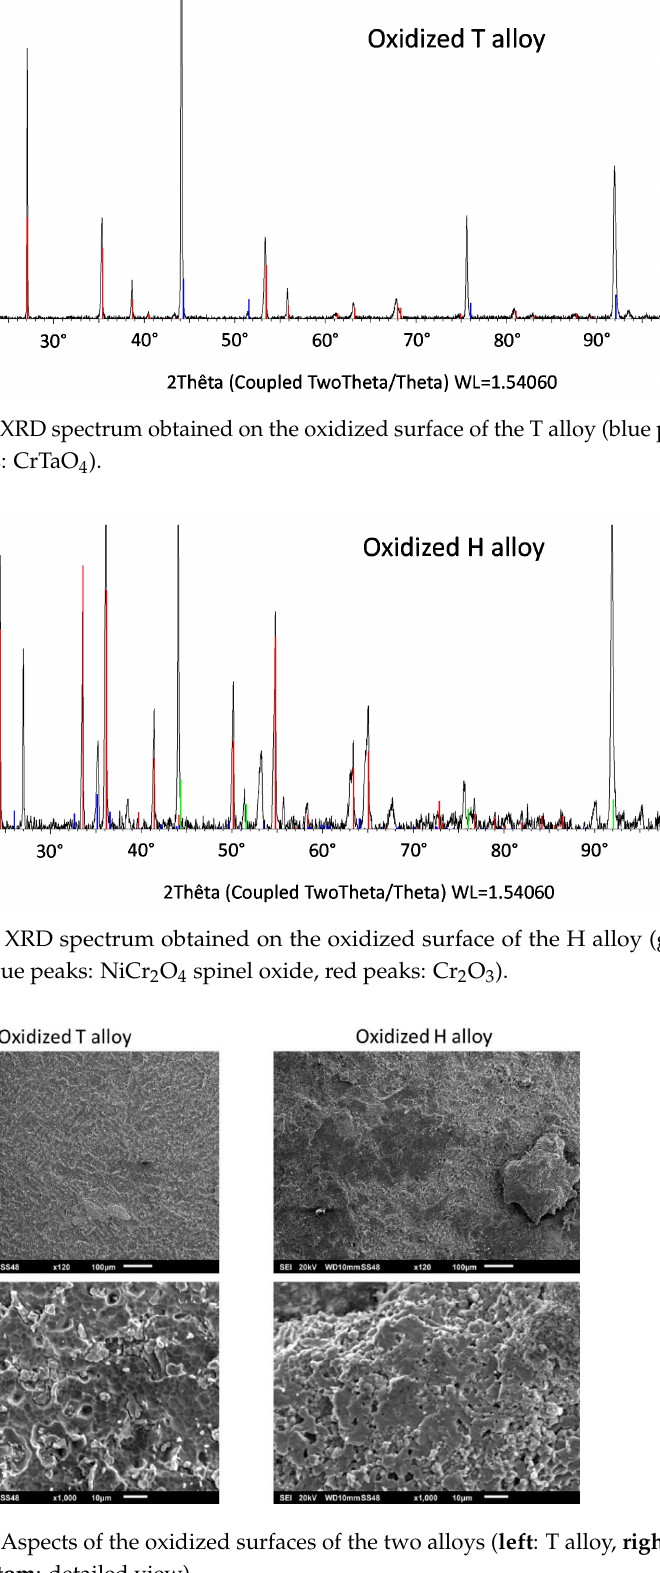
Figure 10. Cross-sectional observation of the surfaces and sub-surfaces affected by oxidation for the two alloys ( left : T alloy, right : H alloy, top : general view, bottom : detailed view).